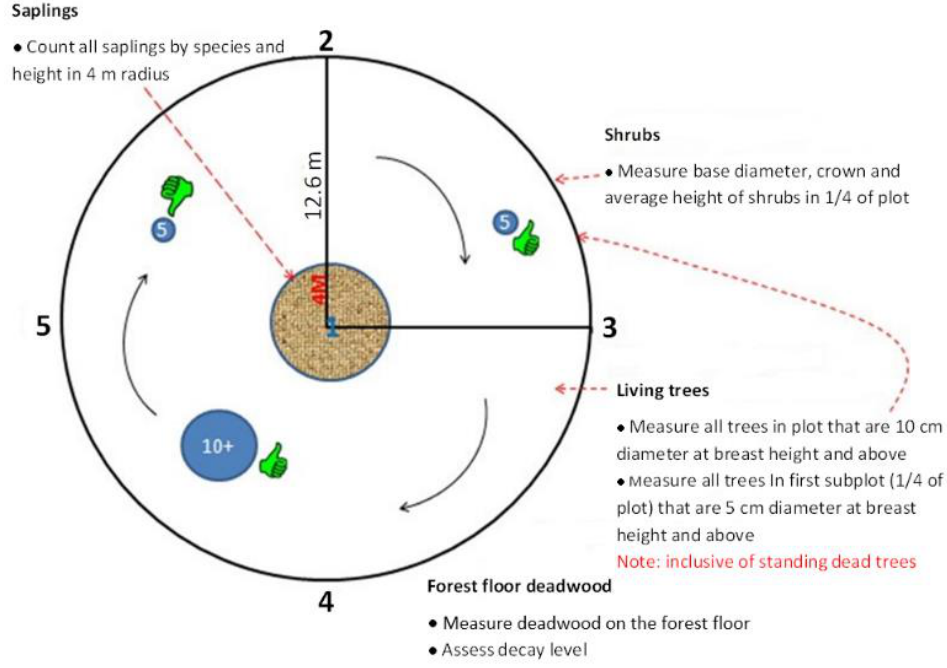
Figure 3. Plot design for the biophysical inventory. Source: FAO & UNHCR, 2017 [17]. In western and southwestern Uganda, AGB stocking data were provided by the National Forestry Authority (NFA) as results of a recently conducted field forest inventory Table 2. LULC classes and AGB stock data used in the AoIs in northern Uganda. which targeted the same AoI. These data were used for each land cover class (Table 3). Table 3. LULC classes and AGB stock data used in the AoIs in western and southwestern